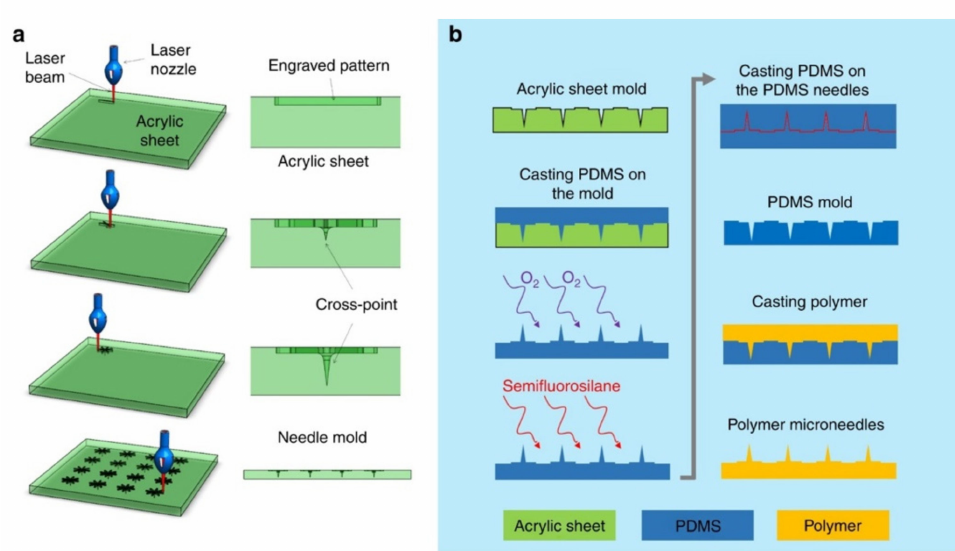
Figure 11. Fabrication of MN mold: ( a ) CO 2 laser cutter was used to fabricate MN acrylic mold using the proposed cross-over lines (COL) technique. ( b ) The acrylic mold was used to fabricate polydimethylsiloxane (PDMS) MNs mold, which can be used to fabricate a variety of polymer- based MNs [125]. Reproduced with permission from Hojatollah Rezaei Nejad et al., Low-cost and cleanroom-free fabrication of MNs; published by Springer Nature,